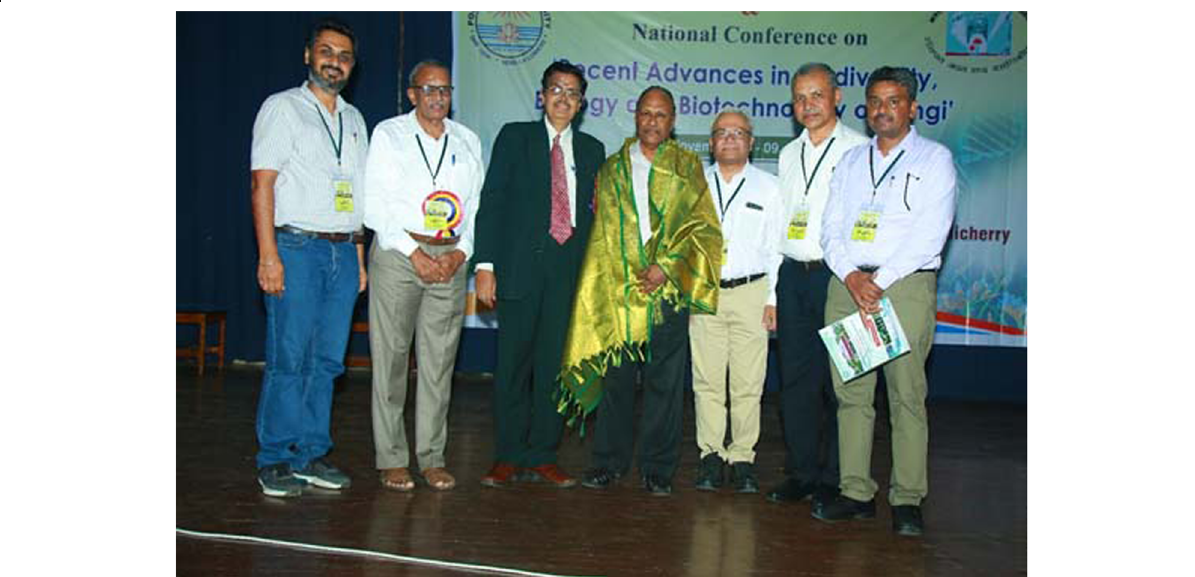
Fig. 16 Chairperson of the first session and lead lecture